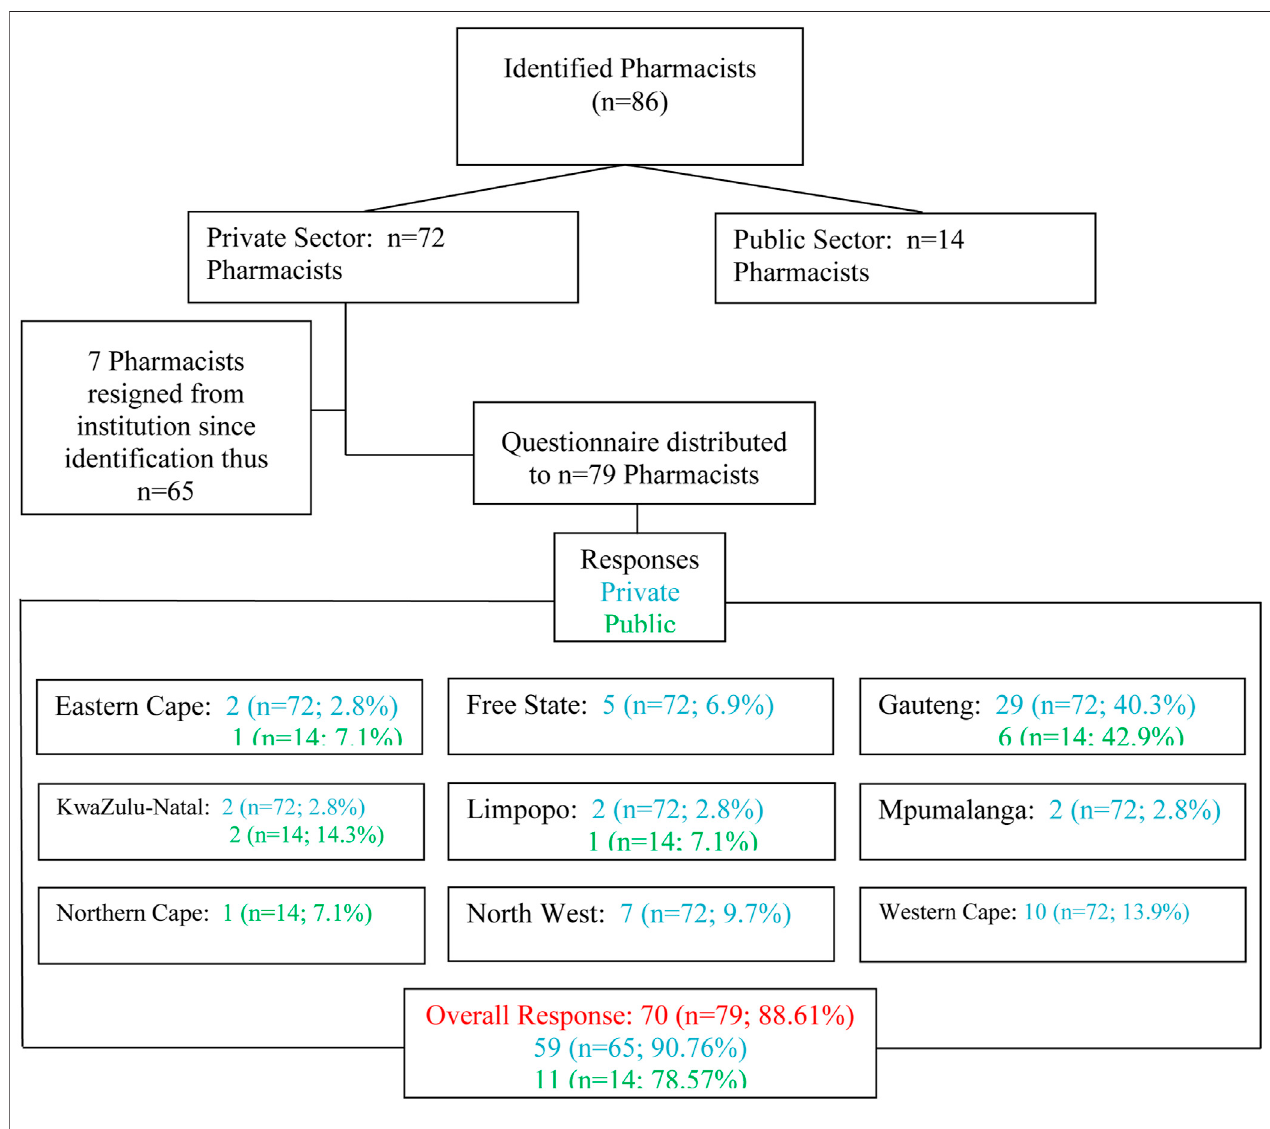
FIGURE 1 | Number of